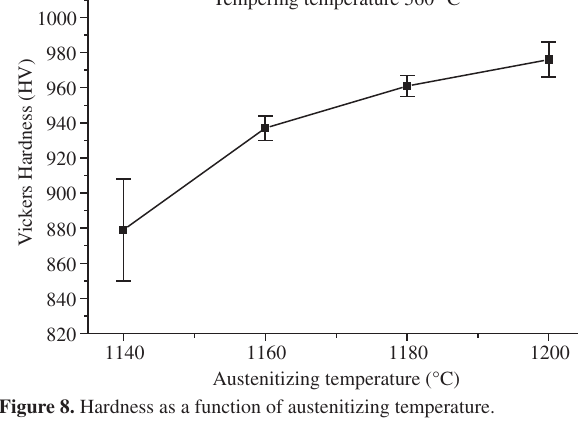
Figure 8. Hardness as a function of austenitizing temperature.